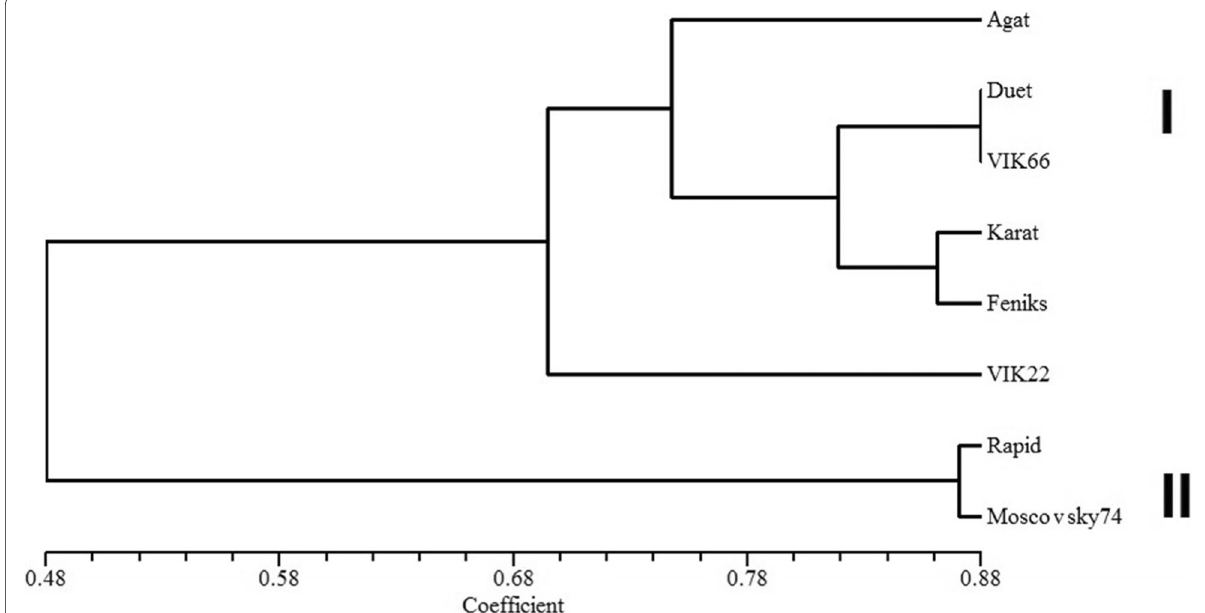
Fig. 2 UPGMA dendrogram of ryegrass cultivars based on the results of genotyping using SCoT markers: I – the first cluster; II – the second